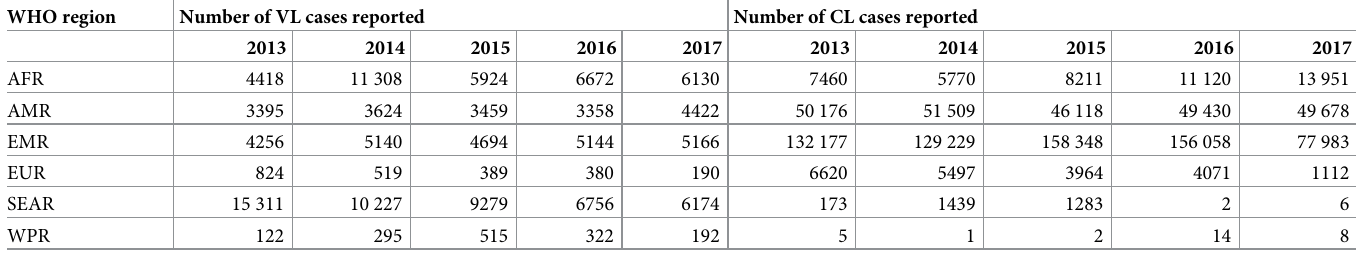
AFR: African Region; AMR: Region of the Americas; EMR: Eastern Mediterranean Region; EUR: European Region; SEAR: South-East Asia Region; WPR: Western Pacific Region.